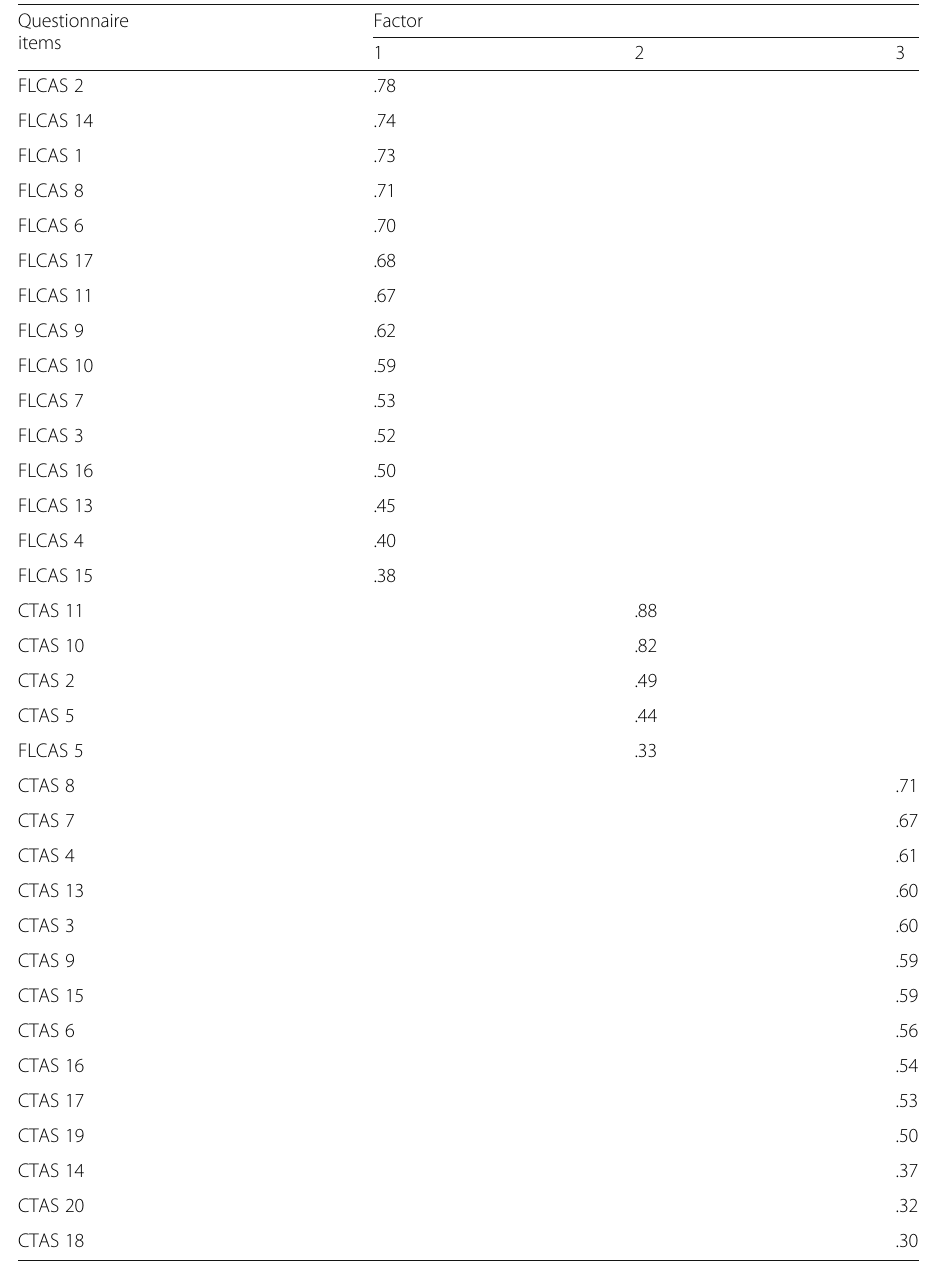
Table 3 Factor structure of the anxiety items Questionnaire